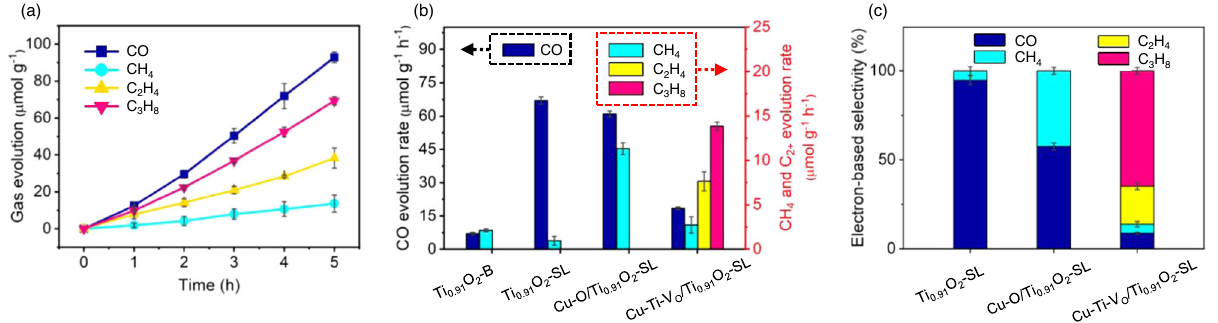
Fig. 3 | Photocatalytic CO 2 reduction performance in acetonitrile aqueous solution.a Photocatalyticproductevolutionasafunctionoflightirradiationtimes on Cu-Ti-V O /Ti 0.91 O 2 -SL. b Productformation rates and c